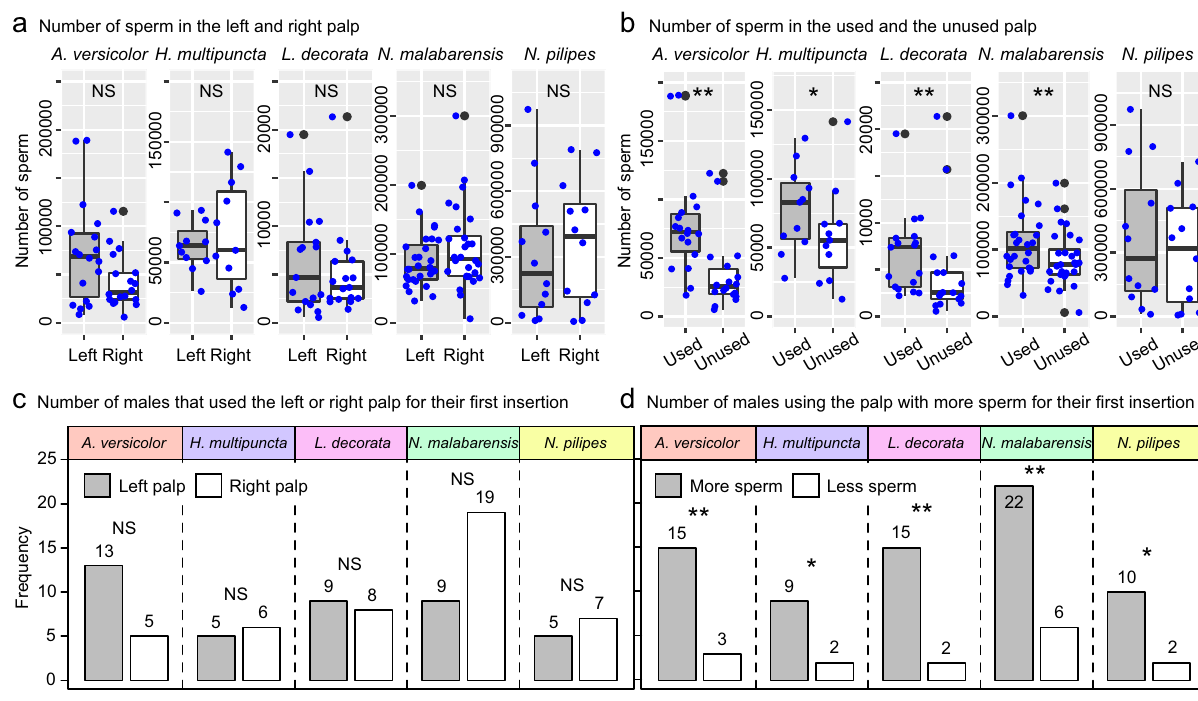
Fig. 1 Number of sperm in male palps and frequency of palp use during the fi rst insertion. a There was no signi fi cant difference in the number of sperm between the left and right palp in all fi ve species. b The number of sperm was higher in the palp used in the fi rst insertion for four species. c Males for all fi ve species had no preference for the left or right palp in their fi rst insertion. d For their fi rst insertion, males chose to use the palp with more sperm for all fi ve species. Boxplots show the median (central line), fi rst and third quartiles (box), and minimum and maximum values (whiskers). NS: not signi fi cant, *: p < 0.05, **: p < 0.01 (for statistical results, see Table 1).